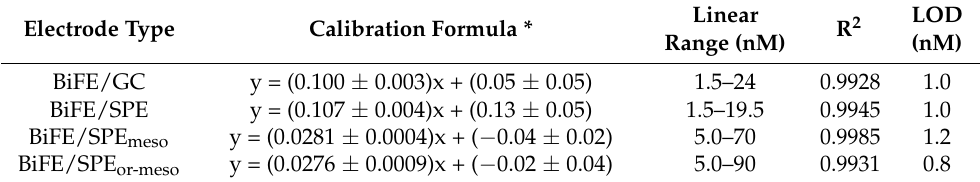
* y and x denote peak current ( µ A) and Ge(IV) concentration (nM); to construct the calibration curve, three replicates for each concentration were